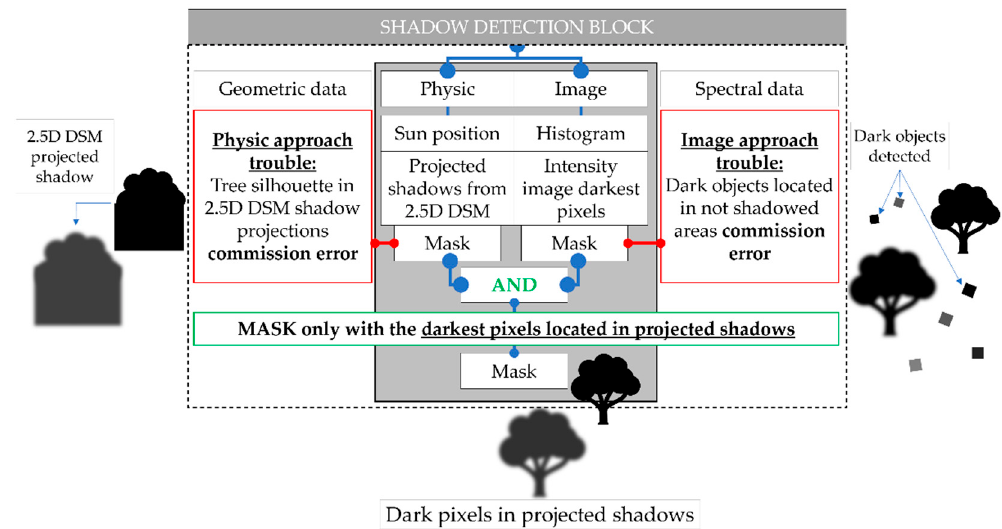
Figure 4. Shadow detection step methodology workflow. Two problems must be solved: (1) when detecting the shadows with a physical approach, the typical DEM (2.5D) does not reproduce the trees silhouette and produces commission error ( left ); (2) when detecting shadows with the image histogram approach, dark objects located in non-shadowed areas also produce commission errors ( right ). The solution is the masking of only those dark pixels located in projected shadow areas.